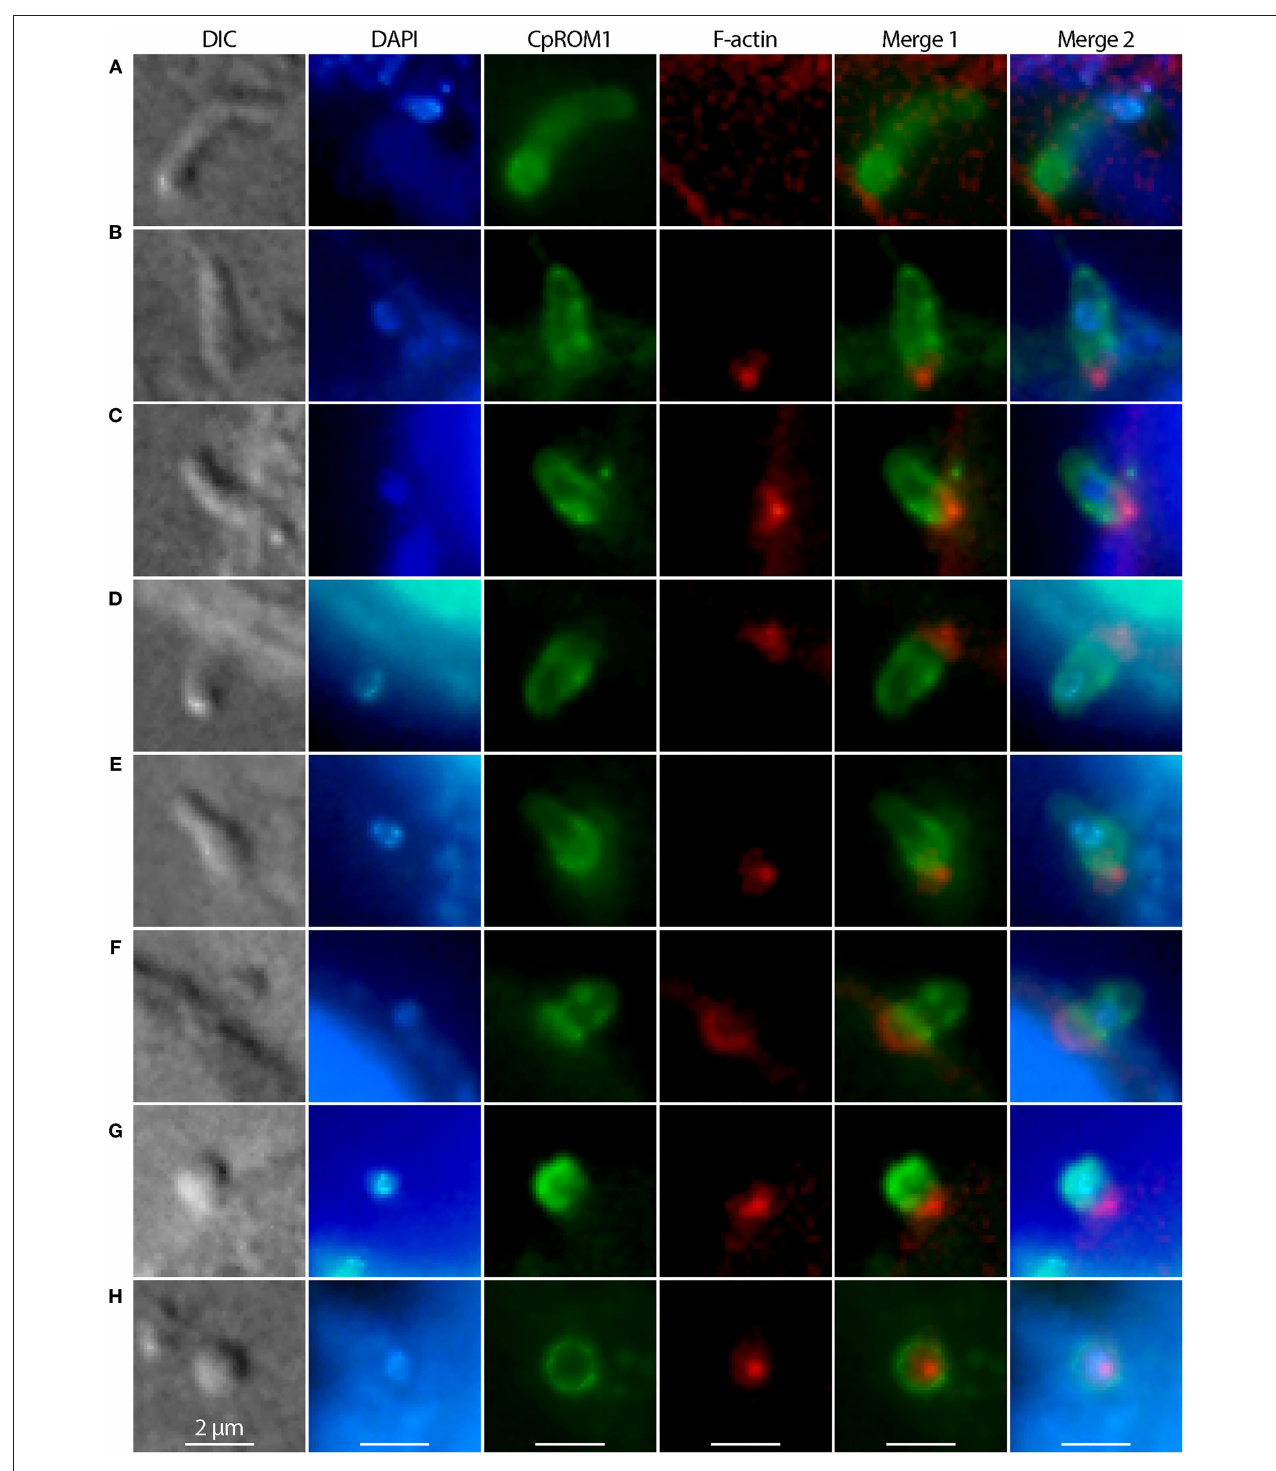
FIGURE 8 | Distribution of CpROM1 (green) in sporozoites during its invasion and transformation into trophozoites, identified using immunofluorescence assays. CpROM1 accumulated in the apex of the sporozoite upon its attachment to the host cell (A) , redistributed to pellicles or subpellicles (B–D) , enriched at the host cell–parasite interface (D–G) , and eventually became relatively evenly distributed on the plasma membrane of the round trophozoite (H) . The morphologies of invading and transforming sporozoites were determined using differential interference contrast (DIC) microscopy. Nuclei were counterstained with 4,6-diamidino-2-phenylindole (DAPI) (blue). Phalloidin–rhodamine (non-reactive to the parasite F-actin) was used to stain host cell F-actin aggregated and accumulated beneath the infection sites (red).